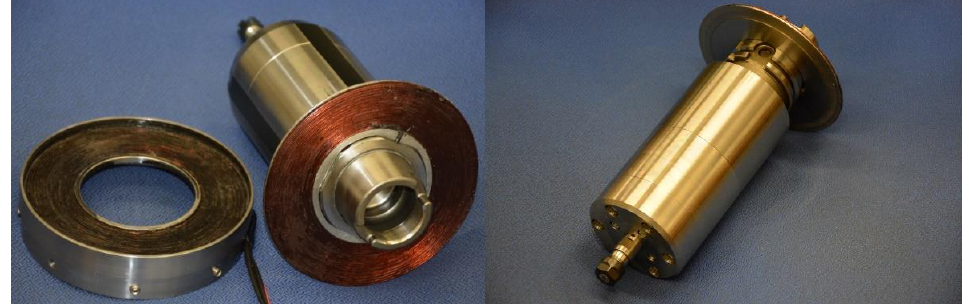
Figure 5. Magnetic couplers located at the top of the machining spindle clamping head.